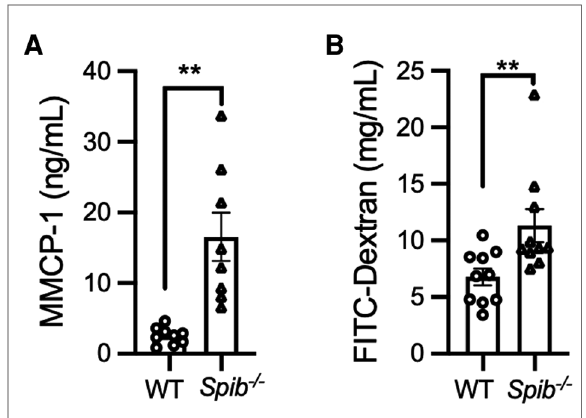
FIGURE 4 Degranulation of intestinal mast cells and increased intestinal permeability in Spib − / − mice at the steady state. ( A ) The steady- state serum level of MMCP-1 was measured by ELISA. ( B ) The fl uorescent intensity of FITC-dextran was measured in the plasma at steady-state. Representative data from at least two independent experiments are shown. Data are expressed as mean±SEM ( n =10 or 11). ** p <0.01, calculated by Mann – Whitney U test.